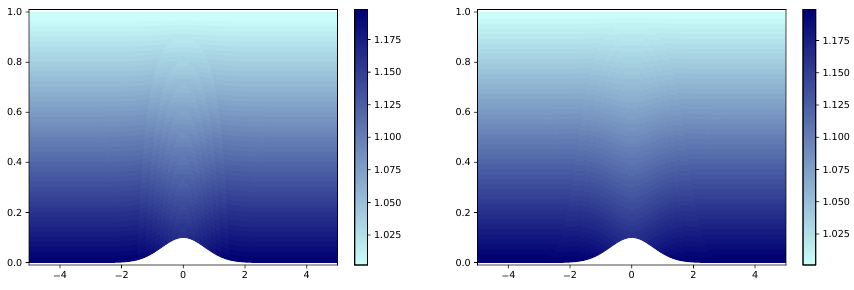
Figure 3. Solution of the ODE (12) for an stratified fluid with M = 50 ( left ) and M = 100 ( right